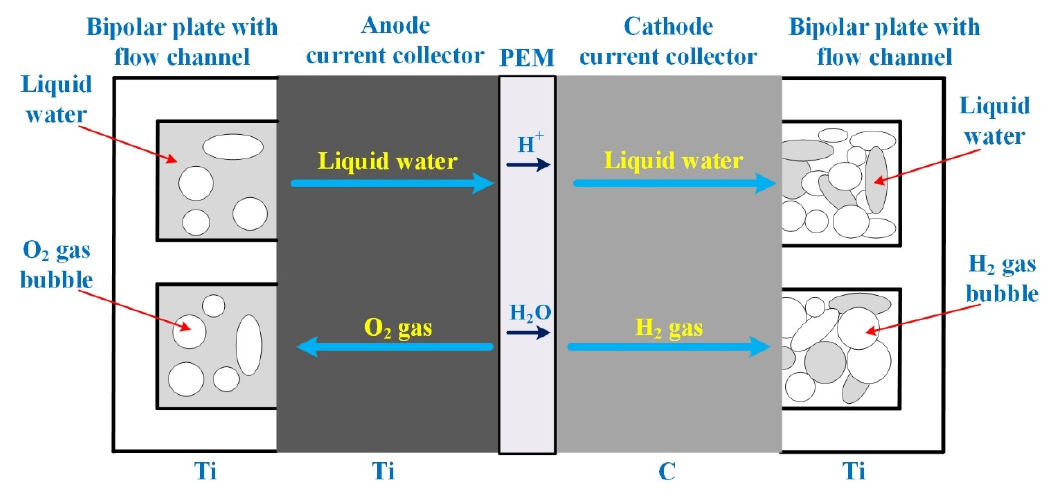
Figure 2. Cross-section of mass transport in a PEM electrolyzer [26].